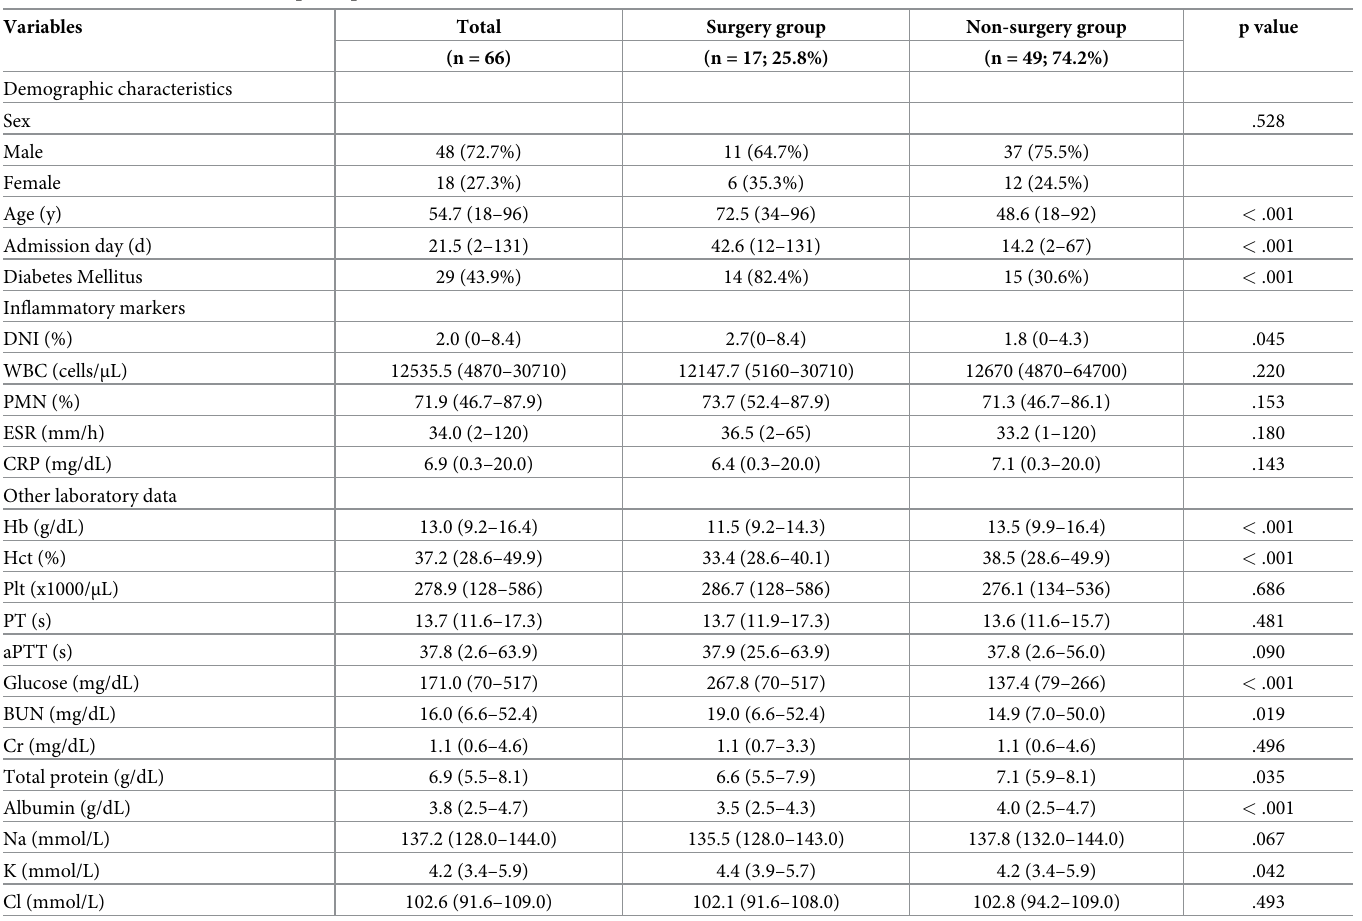
Table 2. Baseline characteristics of participants with foot and ankle infection a .